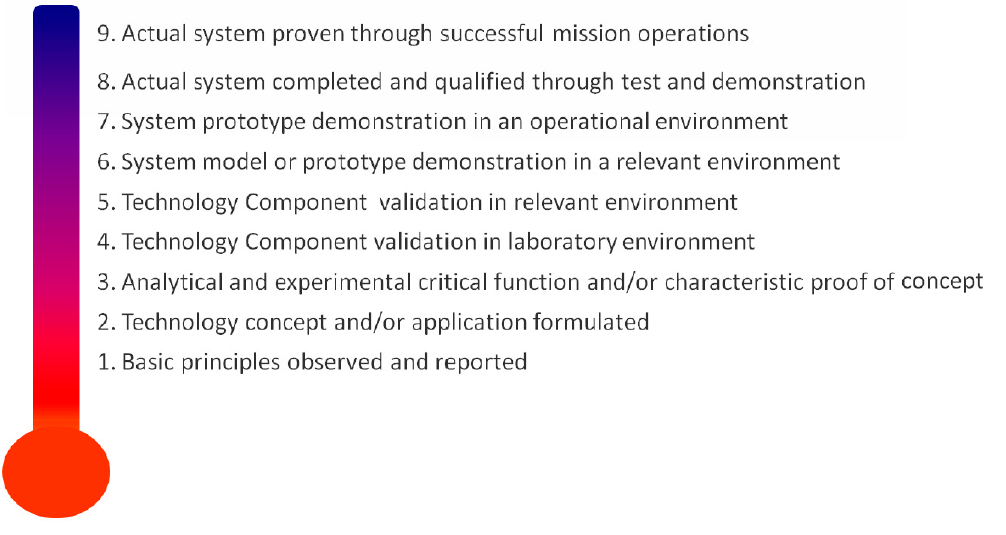
Figure 3. The technology readiness level model (NASA).